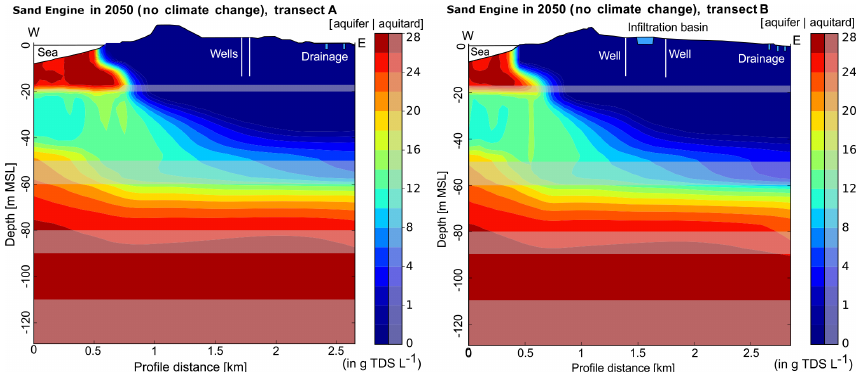
Figure 12. Transects with the simulated groundwater salinity (in g TDS L − 1 ) in 2050 (including Sand Engine, No Climate Change), for transect A and B (as shown in Figs. 2 and 3).